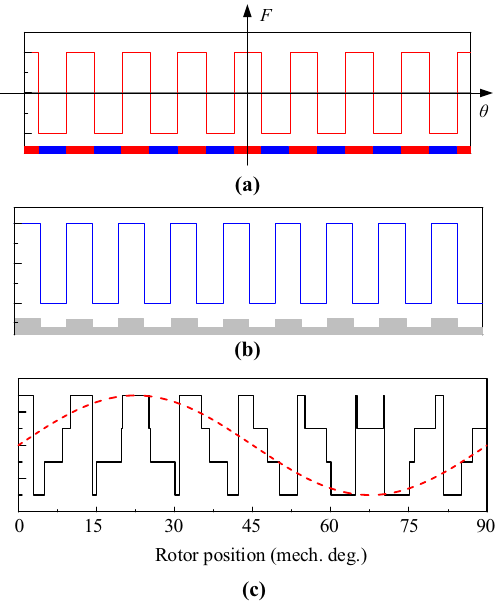
Figure 2. Waveform of MMF, specific permeance and airgap flux density. ( a ) MMF, ( b ) airgap specific permeance, and ( c ) airgap flux